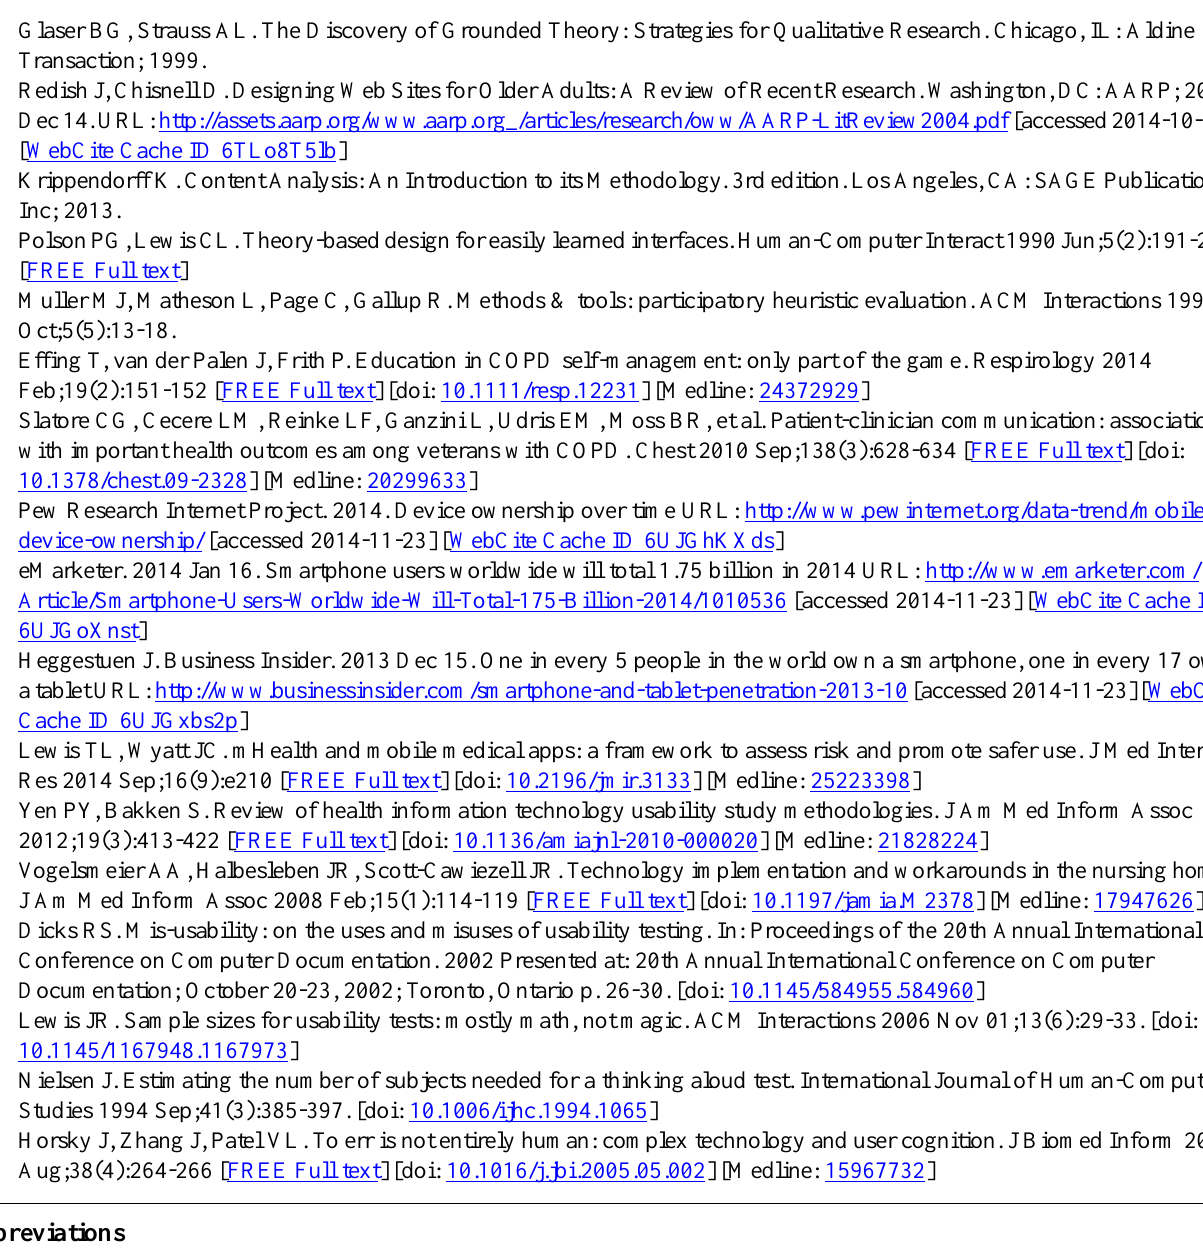
CEnR: community-engaged research COPD: chronic obstructive pulmonary disease eHEALS: eHealth literacy